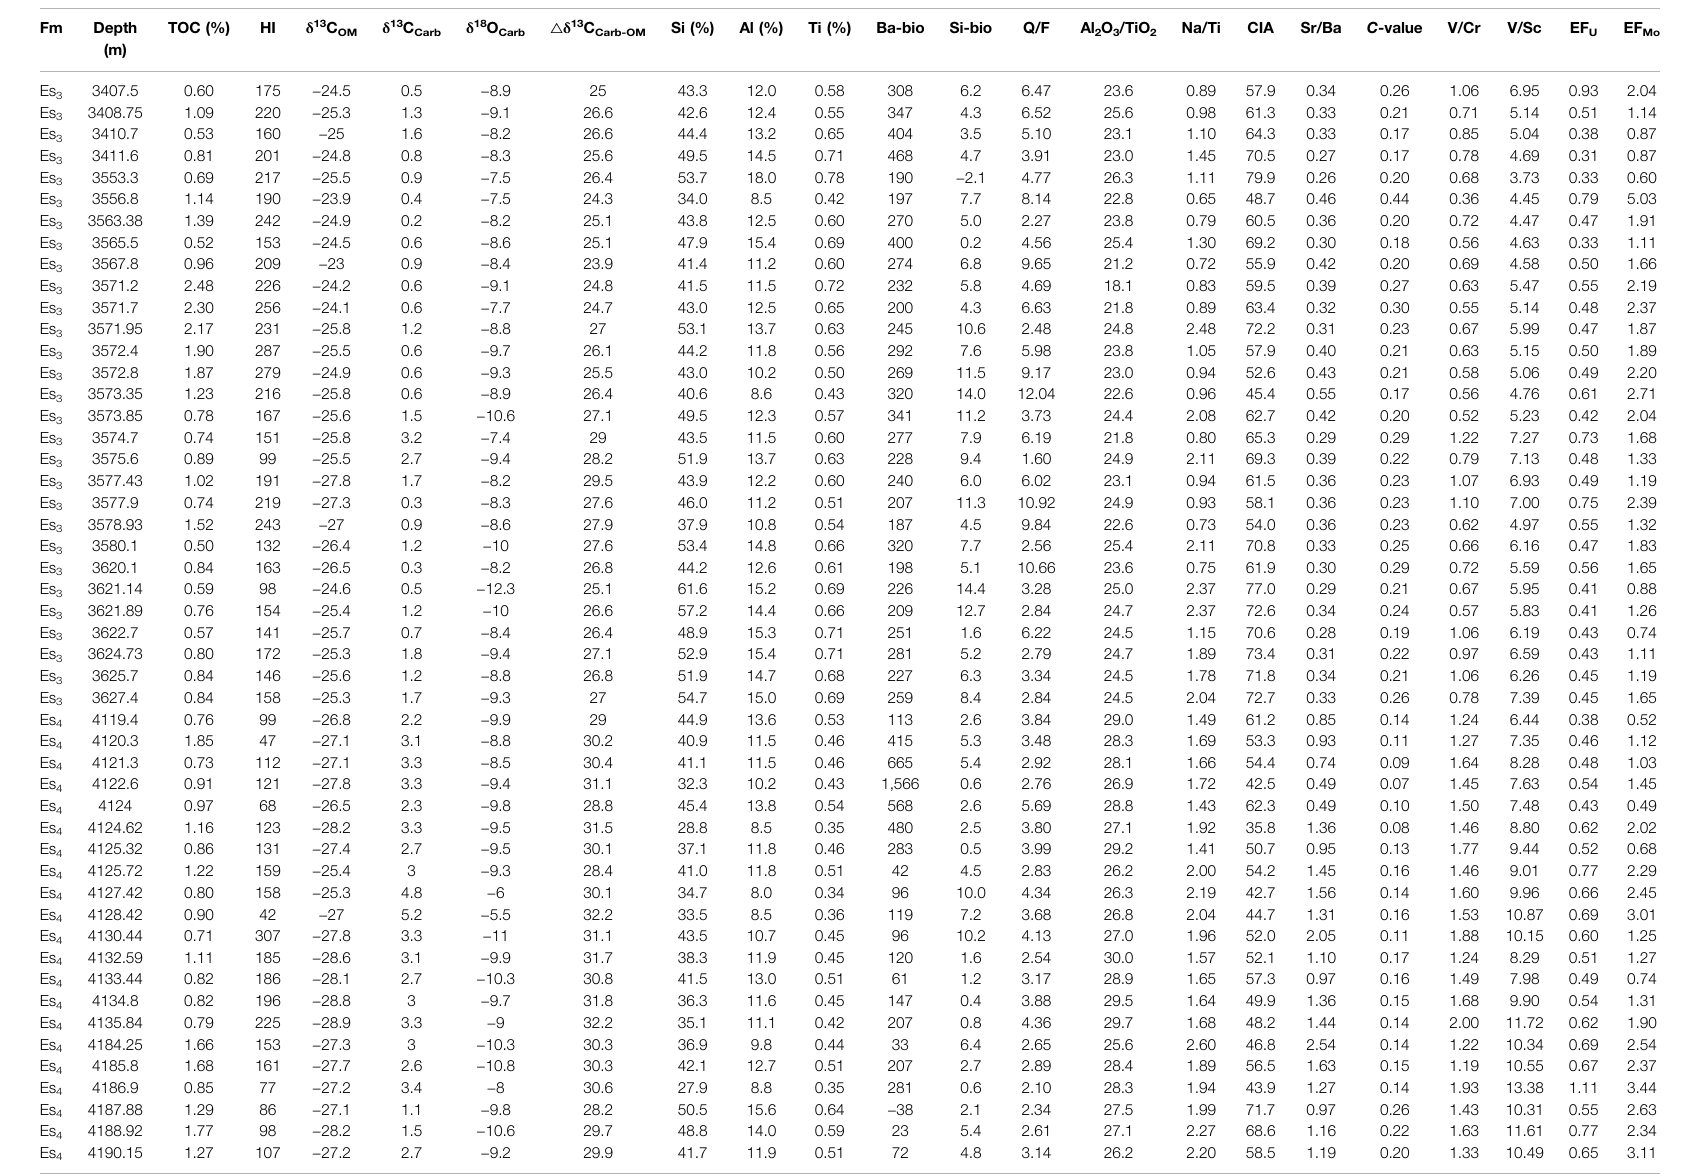
TABLE 1 | Basic sample information and measured TOC, HI, isotopic compositions, some major element concentrations, and proxies utilized in this study. Fm Depth TOC (%) (m)